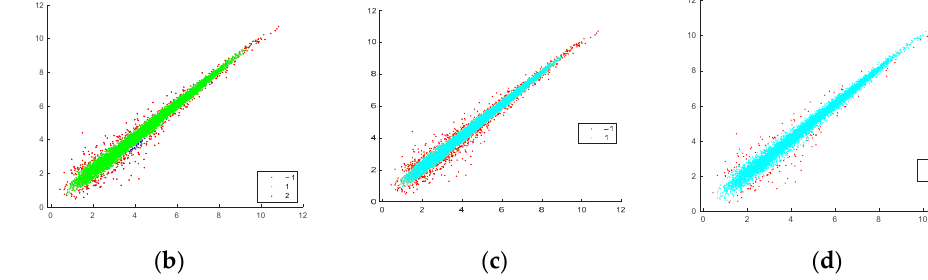
Figure 2. Results of DBSCAN clustering applied to the average values of the genes of the two mice strains ( a ) r = 0.2 and Nmin = 5 discovers 153 differently expressed genes; ( b ) r = 0.2 and Nmin = 15 discovers 420 genes; ( c ) r = 0.2 and Nmin = 20 discovers 593 genes; ( d ) r = 0.4 and Nmin = 20 discovers 154 genes. Discovered core clusters are enumerated in the legends and outliers (red dots) are marked by “ − 1”.